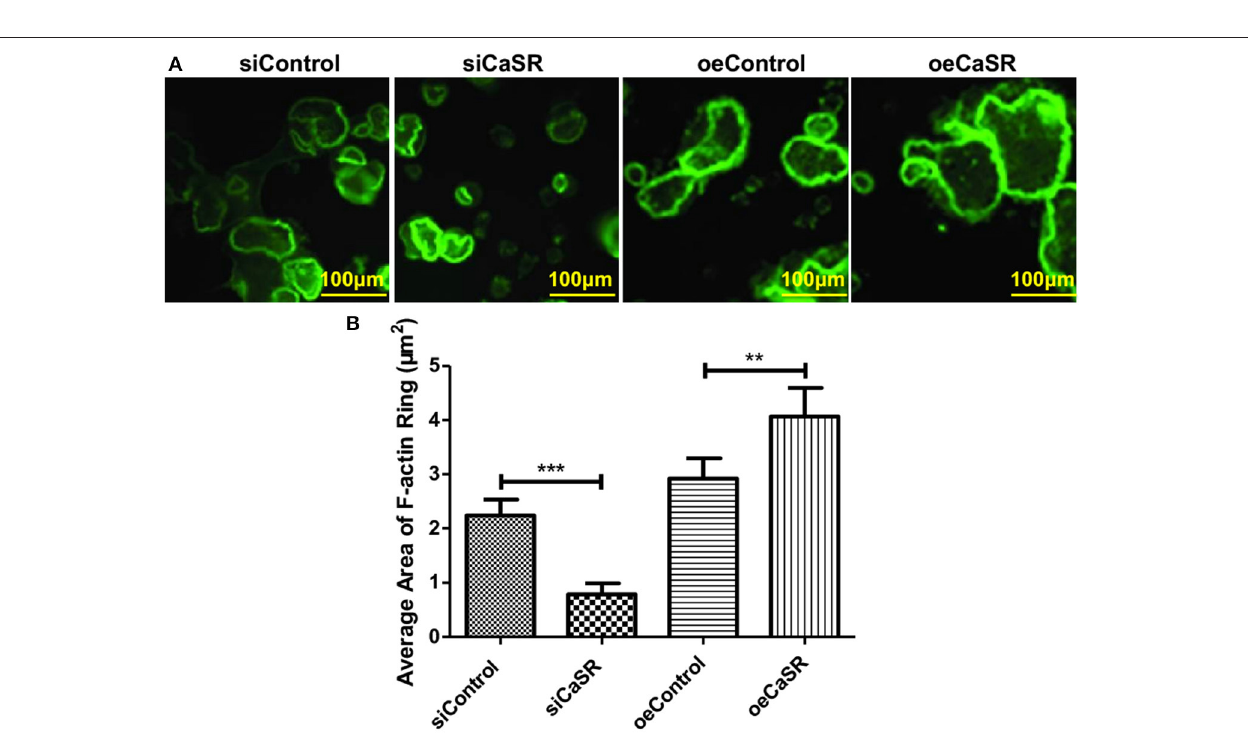
FIGURE 4 | CaSR effect on F-actin ring formation of OCs. (A,B) Four groups of OC precursor cells were treated with CM from modified A549 cells co-cultured with macrophages to examine potential OC differentiation induction. Immunofluorescent staining was used to evaluate F-actin ring formation of OCs. The average area of F-actin ring of OCs was detected and calculated using 400-fold microscope and ImageJ software (NIH). The average area of F-actin ring of OCs in CaSR overexpression group was significantly higher than that in empty vector and negative control groups ( p < 0.001). The difference between negative and empty vector control groups was not statistically significant ( p > 0.05). ** p < 0.01, *** p <